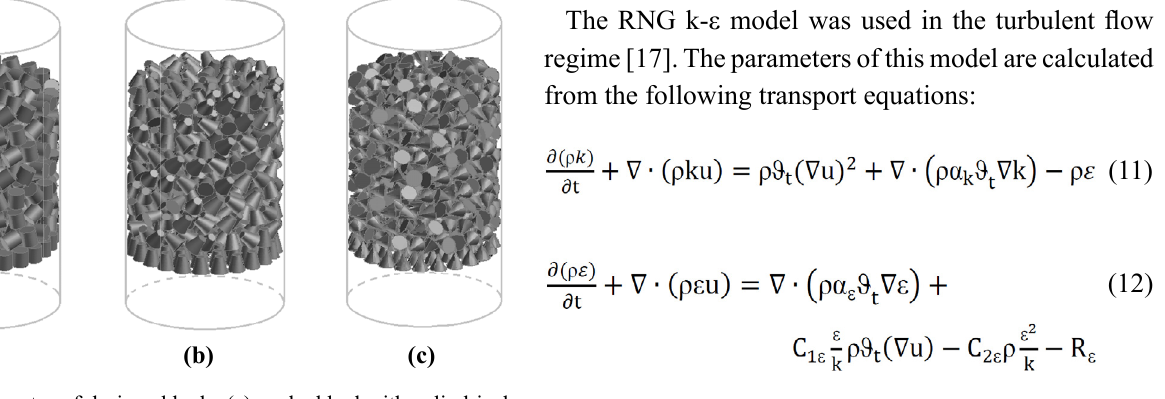
Fig. 2. Geometry of designed beds: (a) packed bed with cylindrical particles, (b) packed bed with truncated cone particles, and (c) packed bed with cone particles.